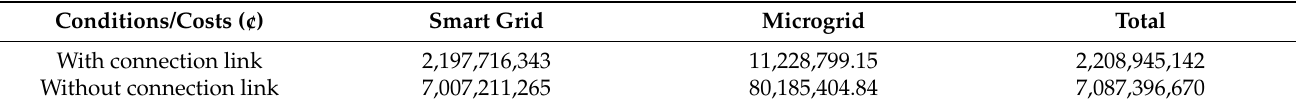
Table 3. Comparison among different